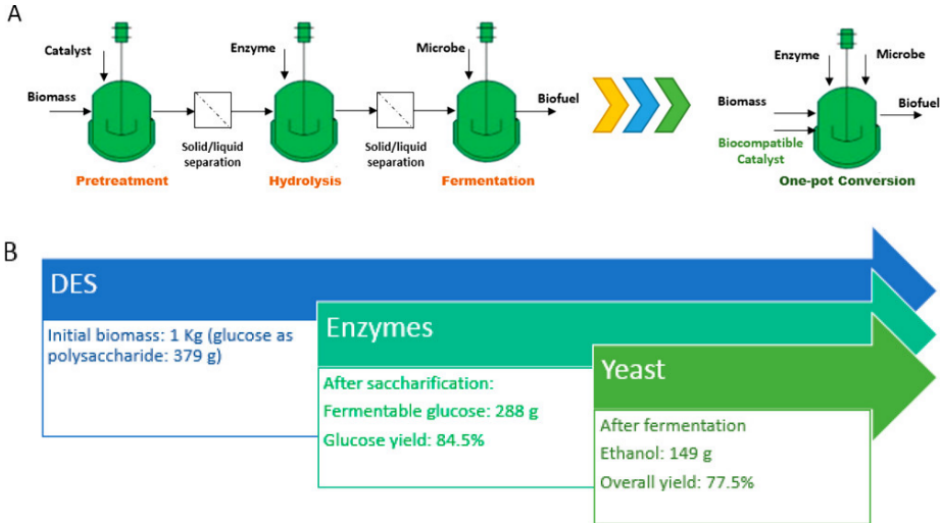
Figure 2. ( A ) One-pot bioethanol production with biocompatible deep eutectic solvents ([Cho]Cl/Glycerol, 1:2 mol/mol) and ( B ) glucose balance of the one-pot bioethanol conversion. Reprinted with permission from Ref. [104]. Copyright 2018, American Chemical Society.